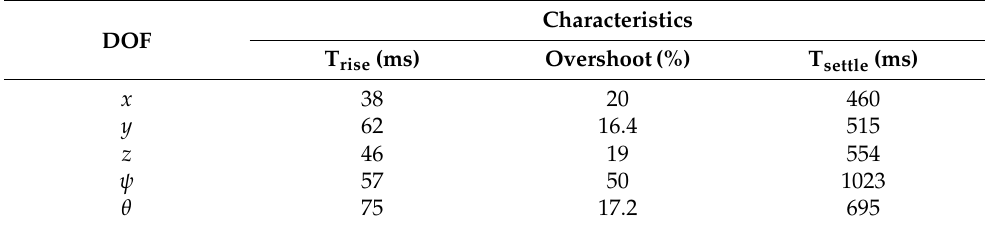
Table 6. Step response